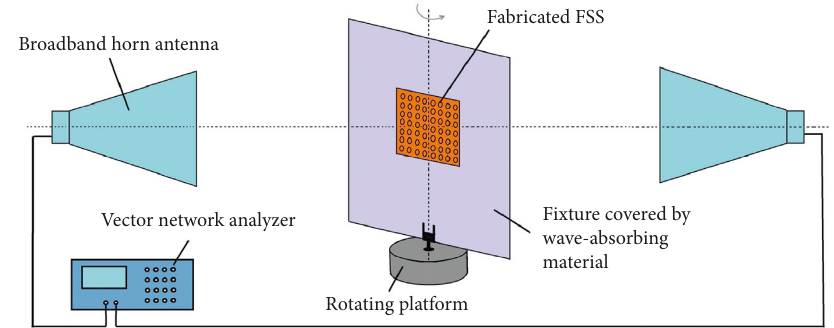
Figure 13: Schematic of the measurement